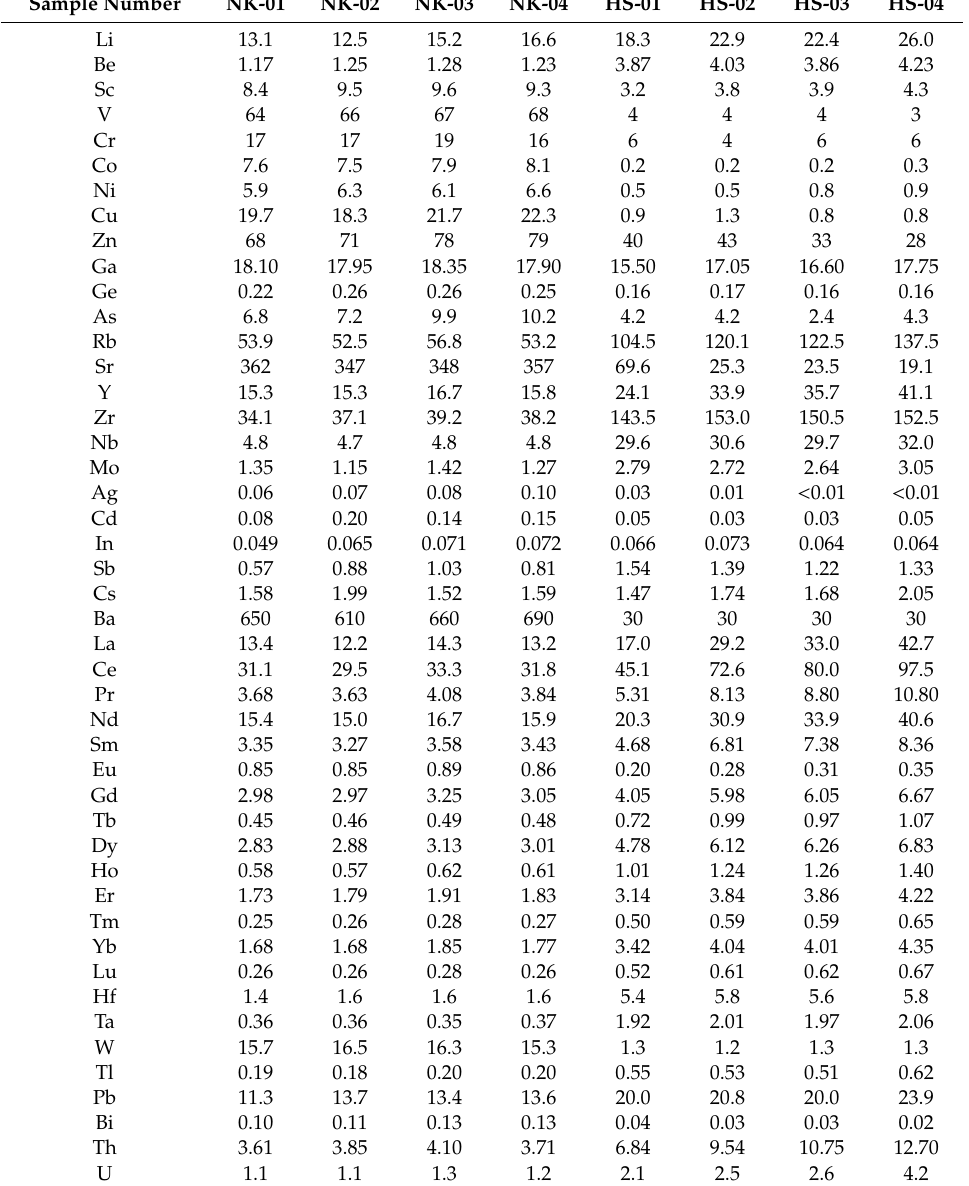
Table 3. Trace element compositions (in ppm) and parameters of the North-Karamay granitoids and the Hongshan